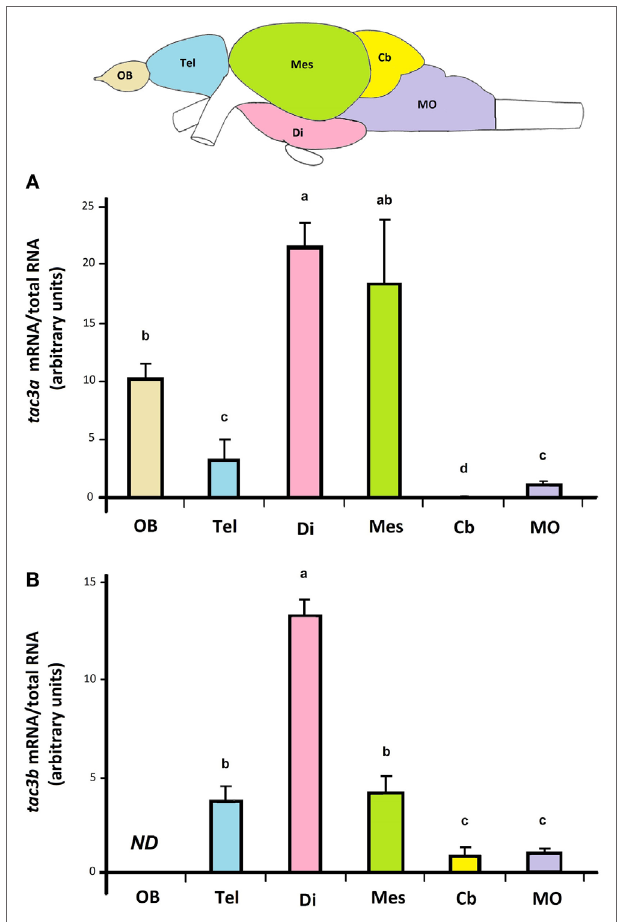
FigUre 4 | Tissue distribution of eel tac3a and tac3b transcripts. Olfactory bulb (OB), telencephalon (Tel), diencephalon (Di), mesencephalon (Mes), cerebellum (Cb), and medulla oblongata (MO) were dissected from prepubertal female eels. The expression of tac3a mRNA (a) and of tac3b mRNA (B) were measured by qPCRs in each brain region and normalized to total RNA. Each bar represents the mean ± SEM from 10 individual samples. Different letters denote statistical significance ( P < 0.05). Abbreviation: ND, non